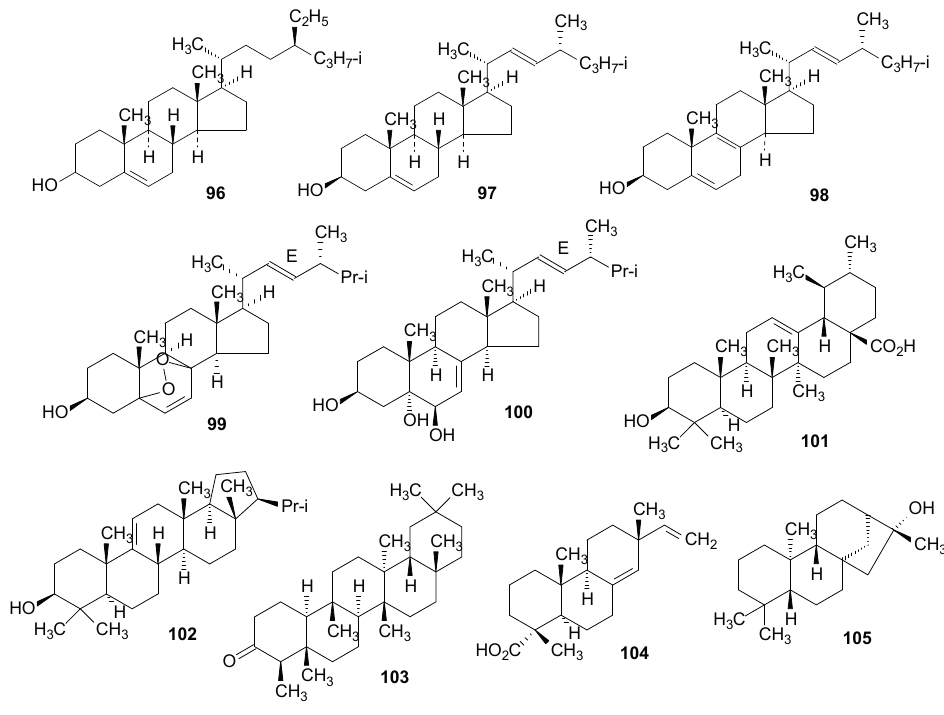
Figure 7. Chemical structures of other compounds: steroids and terpenoids from Ramalina species of lichenized